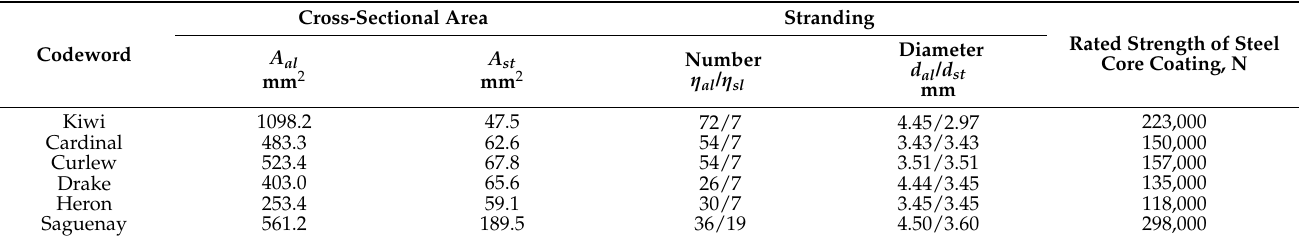
Table 1. Physical and constructional properties of typical